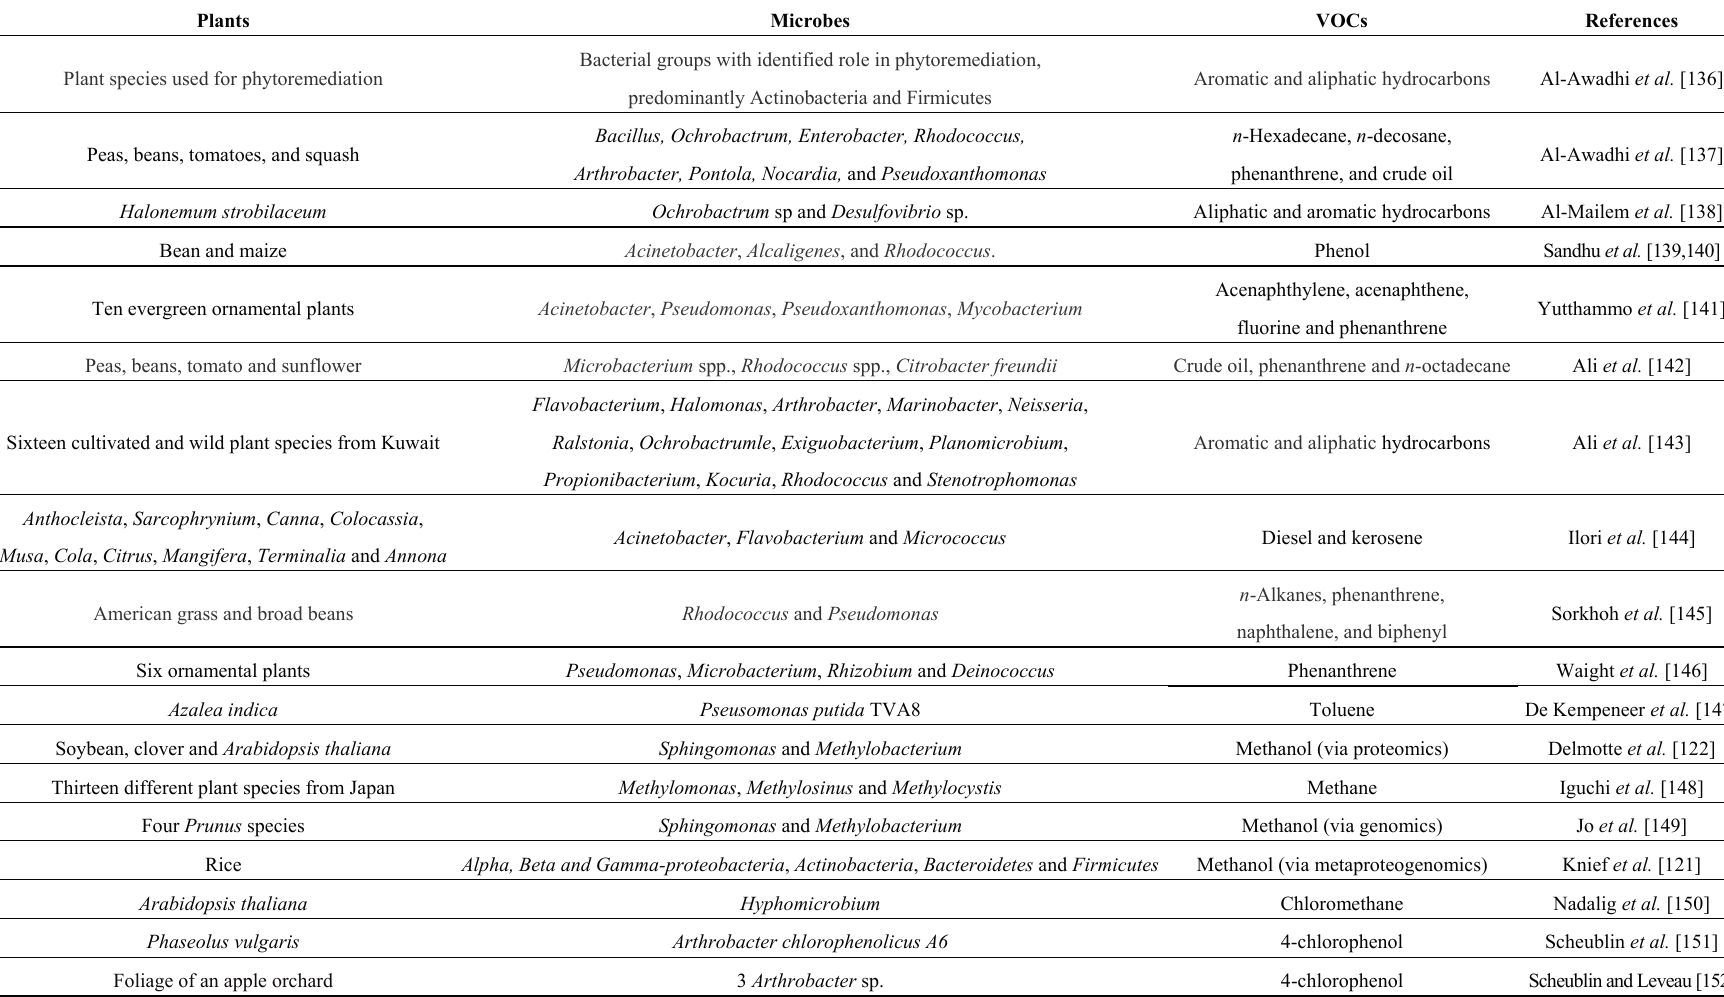
Table 2. Overview of available research on phyllosphere microorganisms in the framework of VOC (including most important AVOCs and BVOCs)